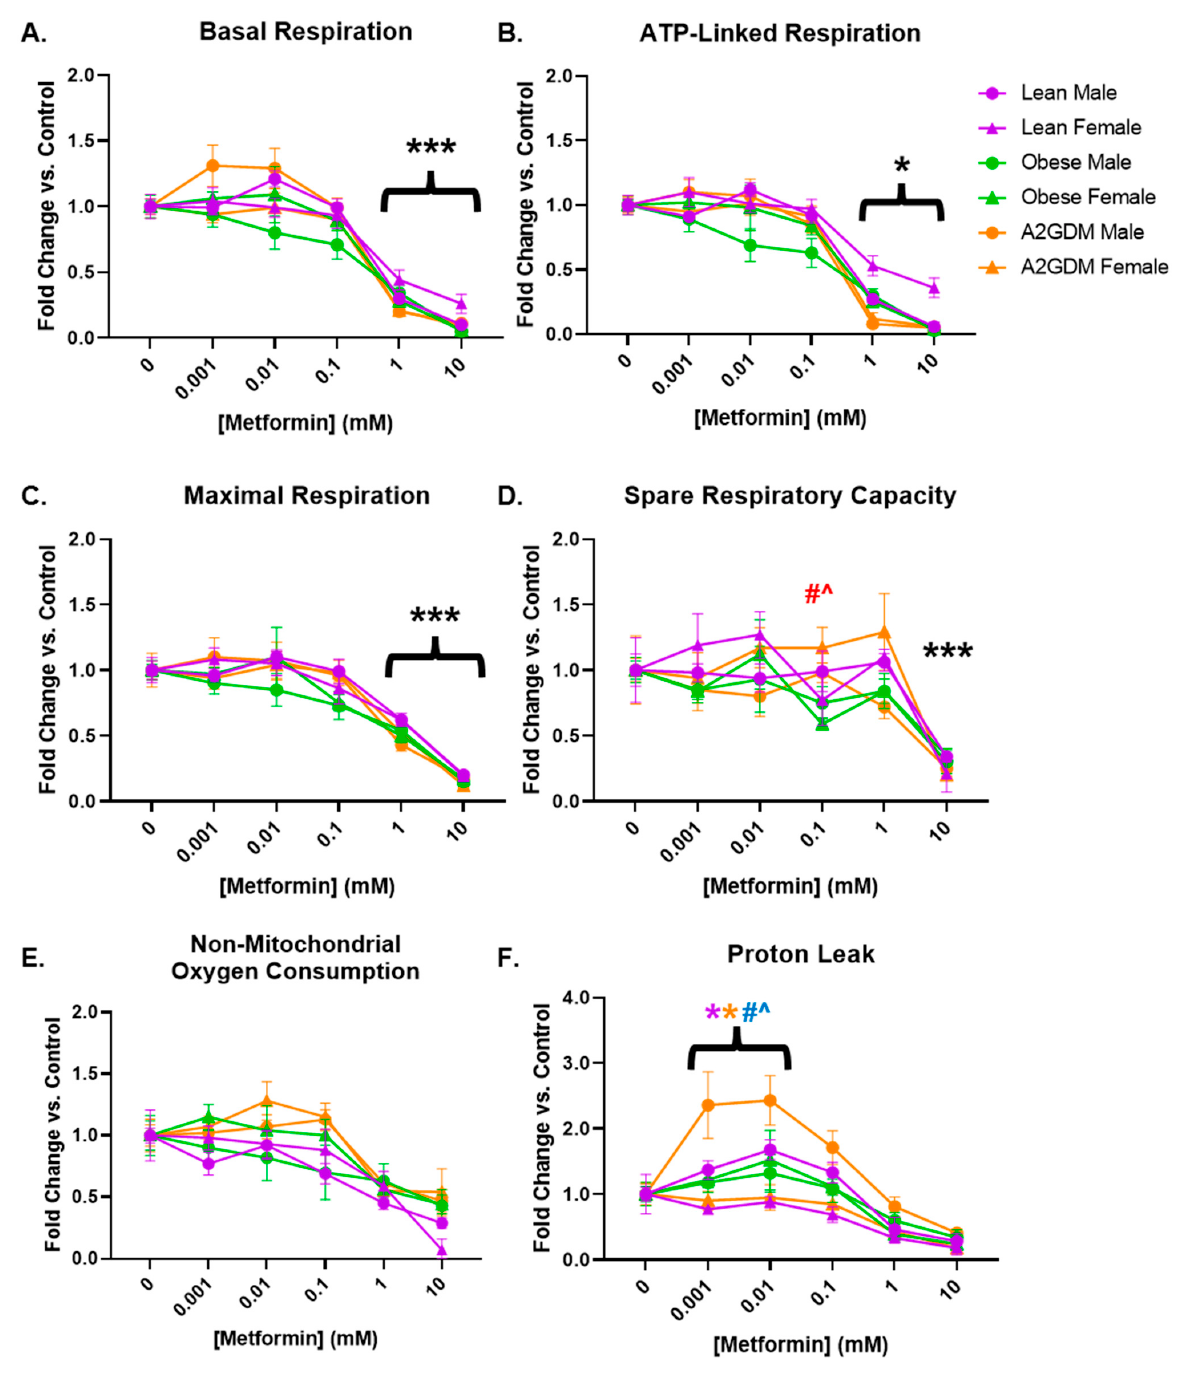
Figure 3. Mitochondrial respiration parameters following metformin treatment: ( A ) basal respiration, ( B ) ATP-linked respiration, ( C ) maximal respiration, ( D ) spare respiratory capacity, ( E ) non-mitochondrial oxygen consumption, and ( F ) oxygen consumption related to proton leak in syncytiotrophoblast of lean, obese and A2GDM women with either a male or female fetus. Values, normalized to corresponding no treatment control, expressed as means ± SD. Statistical assessment was performed using 2-way ANOVA with Tukey post hoc. Level of significance: One symbol: p < 0.05. Two same symbol: p < 0.01. Three same symbol: p < 0.001. *: Significant difference in all groups vs. control (no metformin). Difference at indicated metformin concentrations: Between sexes within group: Lean *, Obese *, A2GDM * . Lean vs. Obese Males † and Females †. Lean vs. A2GDM Males # and Females #. Obese vs. A2GDM Males ˆ and Females